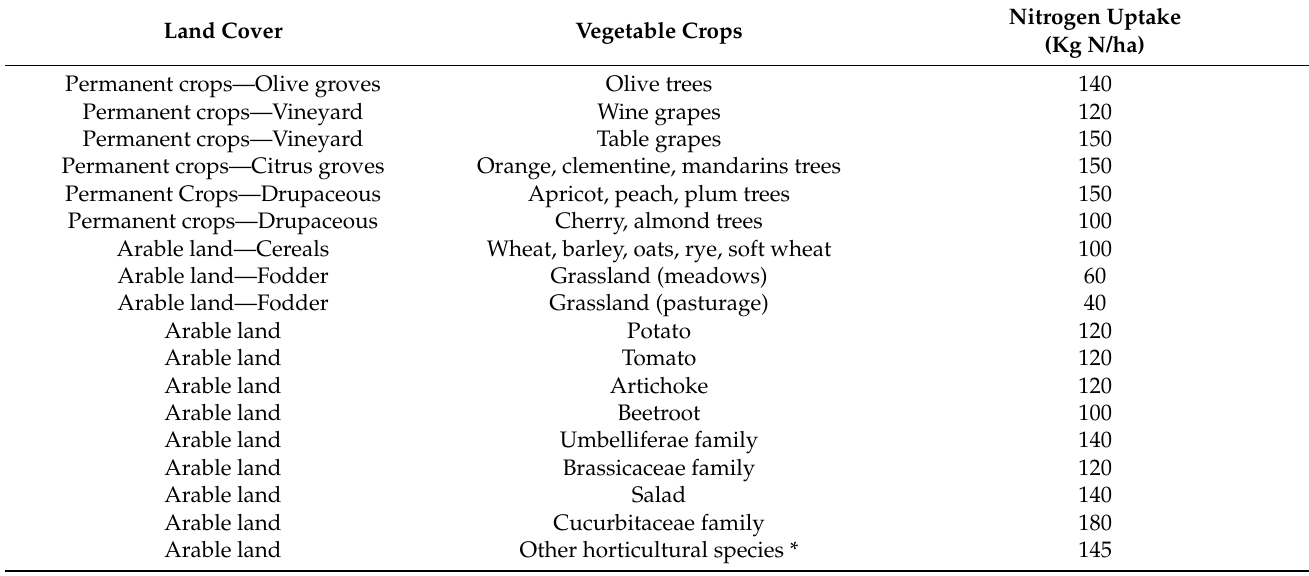
Table 2. Nitrogen uptake in the most widespread vegetable crops in the Puglia region